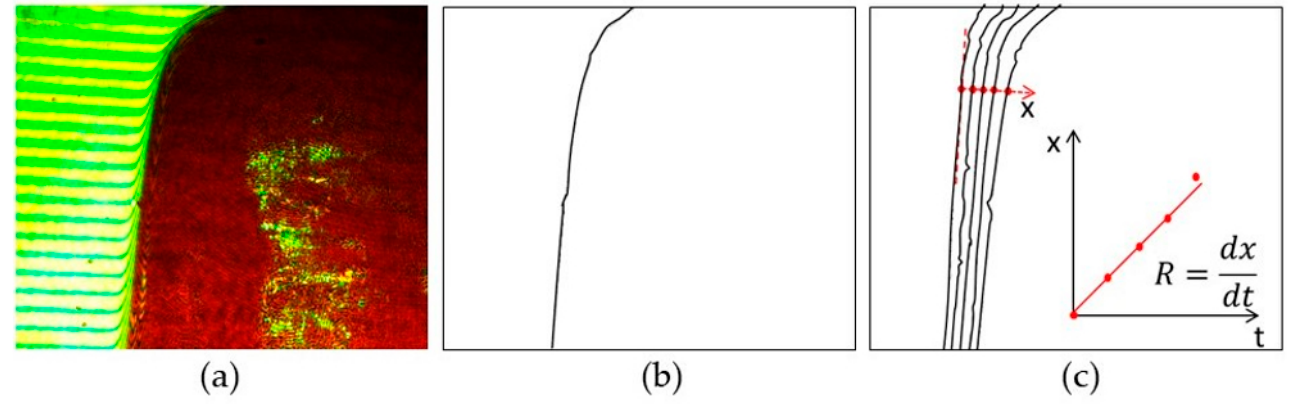
Figure 4. Determination of the face displacement velocity: ( a ) original image, ( b ) crystal outline and ( c ) determination of the face displacement velocity.